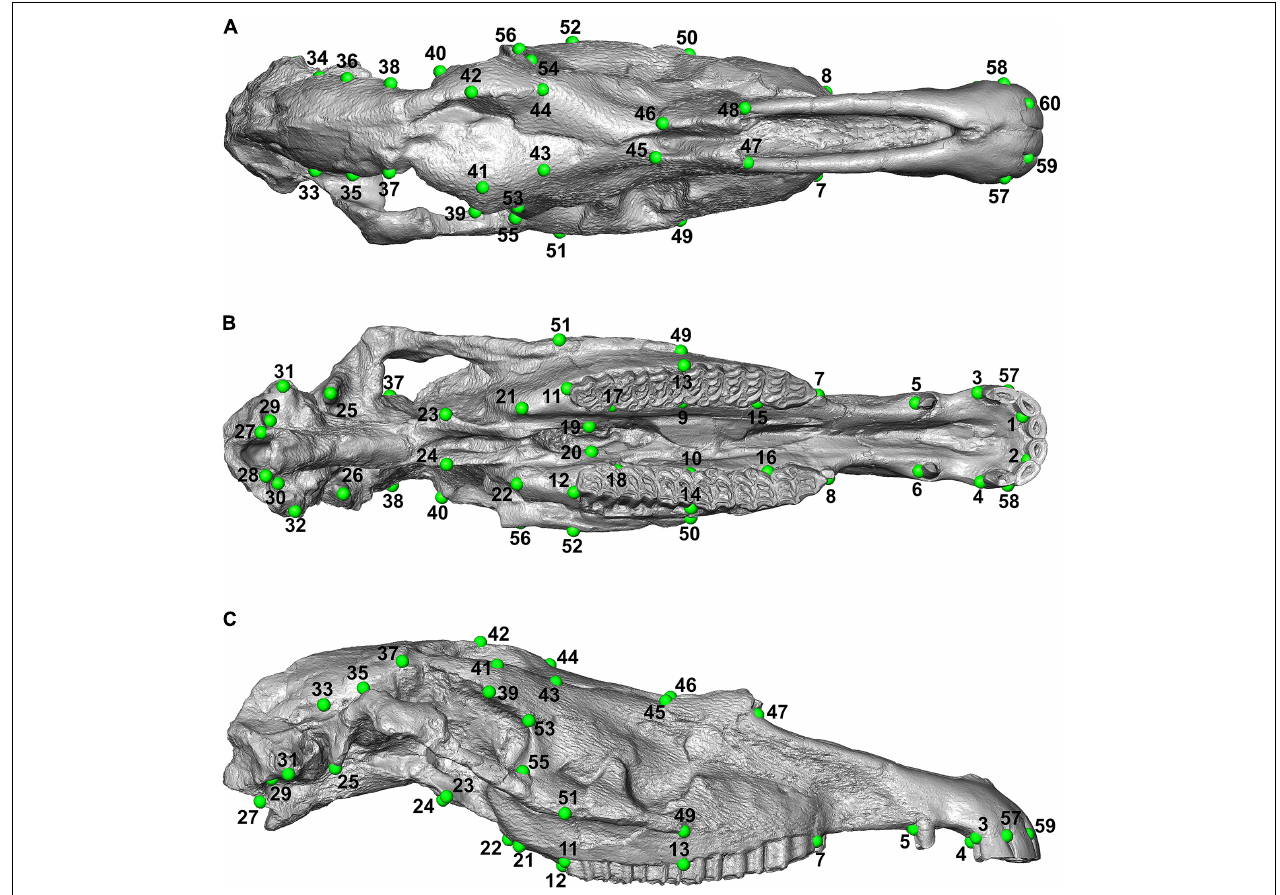
FIGURE 4 | Landmark configuration used on IGF560. (A) Dorsal view; (B) ventral view; (C) lateral view.